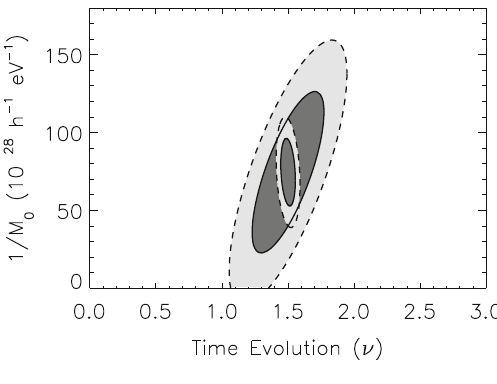
Fig. 33 68% (dark grey) and 95% (light grey)